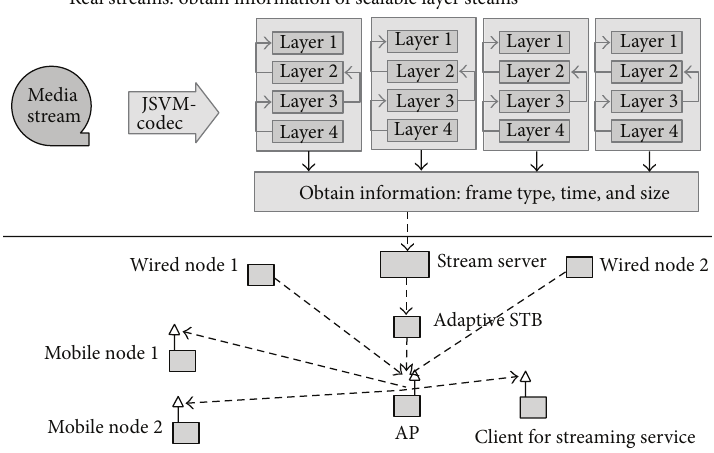
Figure 6: Simulation environment.